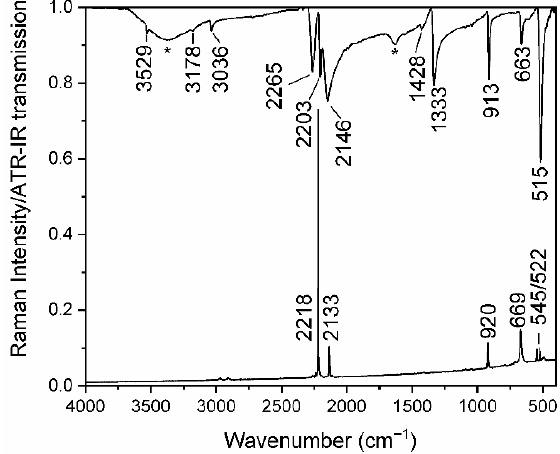
Figure 3 . IR and Raman spectra of LiCs 2 [dca] 3 . The asterisks mark vibrations of water.